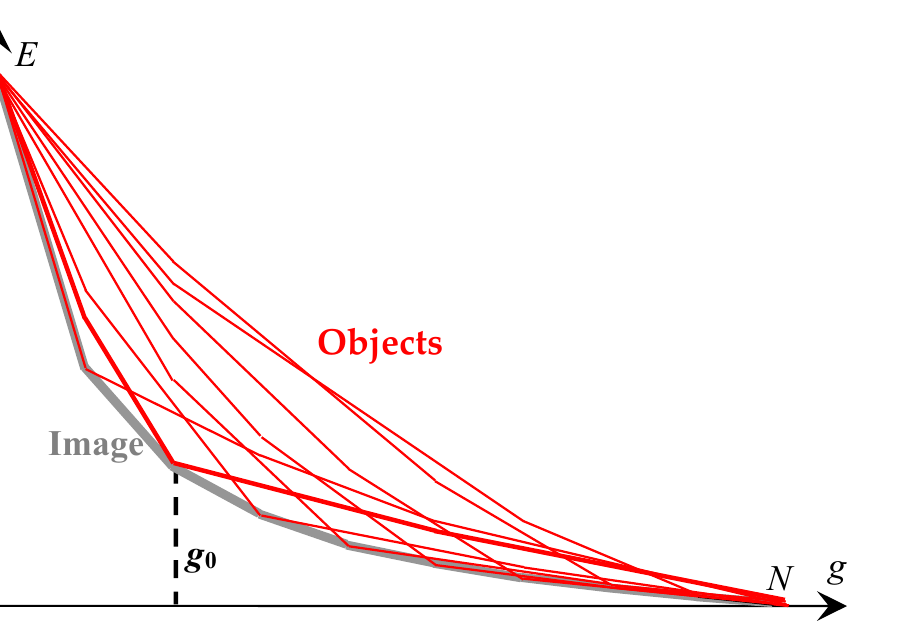
Figure 11. Parameterized approaching of an image by a hierarchical sequence of approximations in g 0 = 1, 2,..., N colors. The lower gray convex curve describes E g sequence of optimal image approximations. The remaining red convex curves describe the hierarchies E g sequences of image approximations each containing at least one optimal approximation, in g 0 = 1, 2,..., N colors.